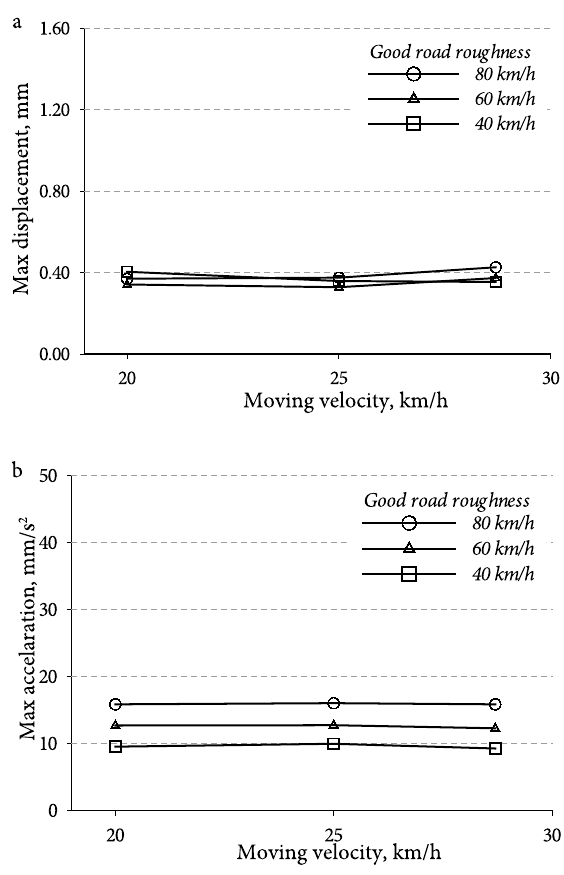
Fig. 13. Characteristics of vibration according to moving velocity and road roughness: a – displacement; b – acceleration